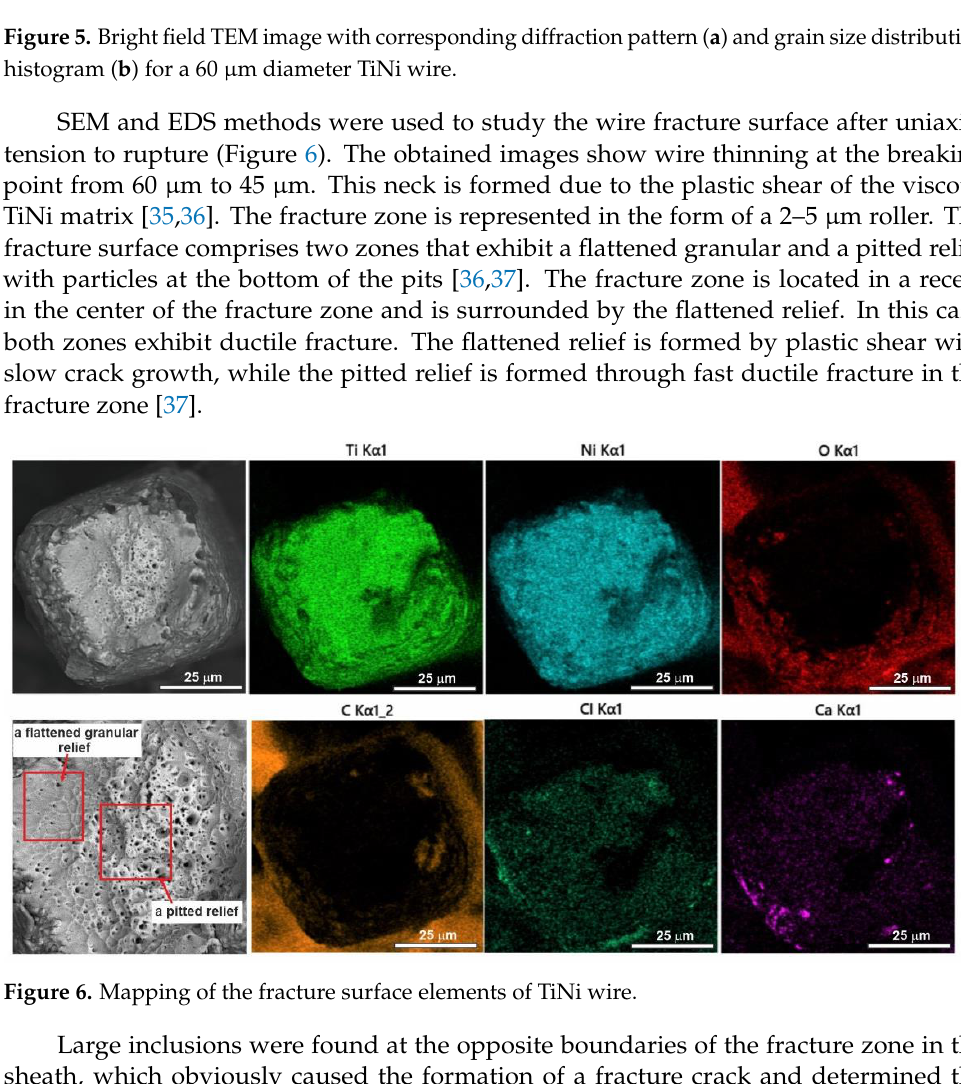
Figure 6. Mapping of the fracture surface elements of TiNi wire.